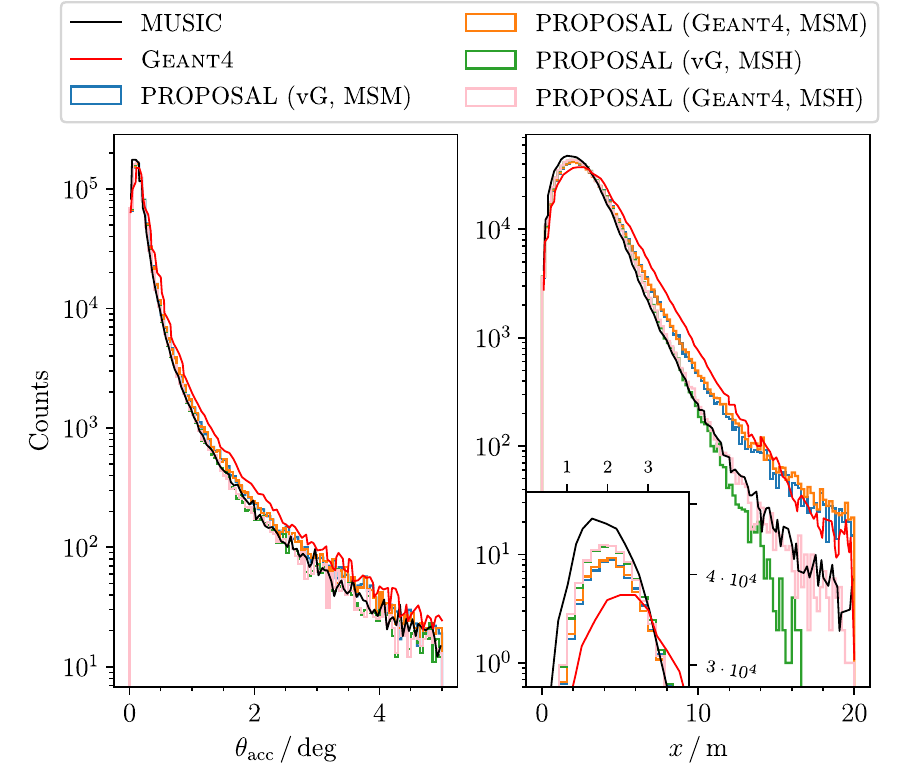
Fig. 2 A comparison of the results of MUSIC, Geant4 , and PRO- POSAL is presented for 10 6 muons propagated with E i = 2 TeV over a distance of 3 km in water. A v cut = 10 − 3 is set. In PRO- POSAL, bremsstrahlung and photonuclear interaction deflections are parametrized either by Van Ginneken (vG) or as in Geant4 . Both mul- tiple scattering by Molière (MSM) and Highland (MSH) are checked. Left: The accumulated deflection θ acc in degree is very similar in all Table 2 The survival probability p s defined by the ratio of all muons that reach the propagation distance of 3 km and the amount of muons stopping before due to large energy losses and muon decays, the mean survived muon energy E f , the mean scattered angle θ , and the mean